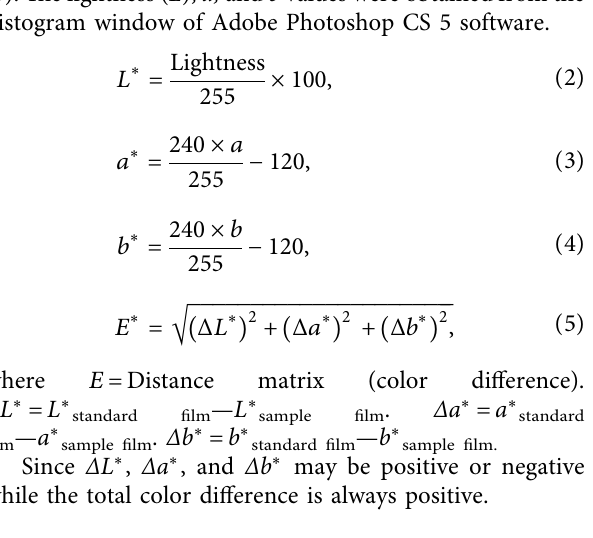
color, which ranges from black at 0 to perfect white at 100.